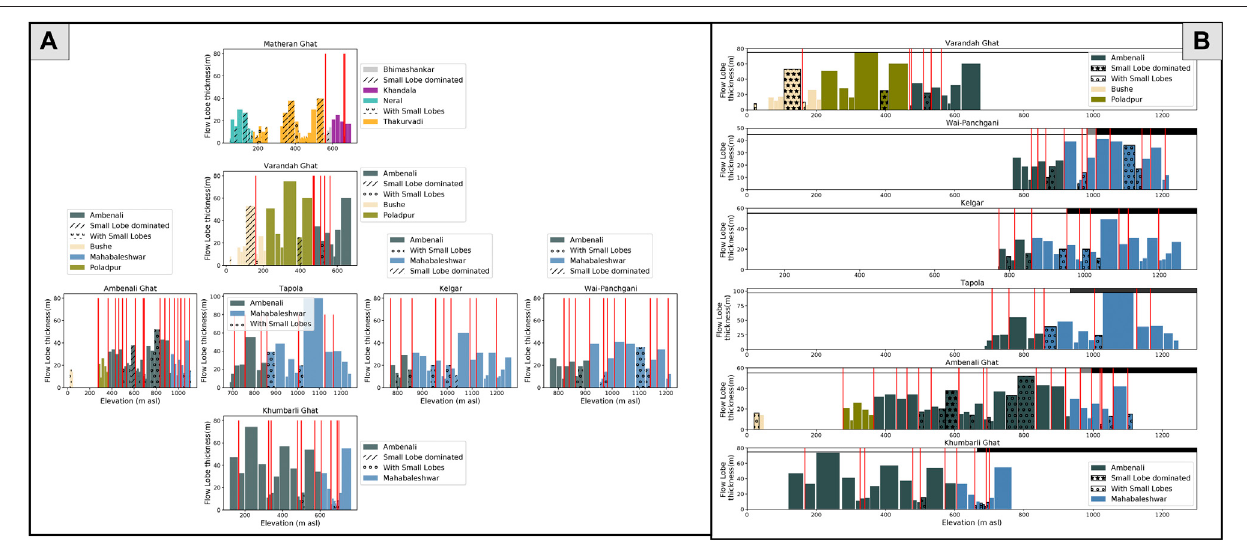
FIGURE 4 | (A) Plots of lobe thickness in each Deccan lava formation vs altitude above mean sea level for traverses in central Western Ghats area; width of bar (cid:1) lobe thickness (see Figure 1B fortraverse locations).Formations areshown bybar color(see key); +opendots (cid:1) withsmall lobes; +stars (cid:1) small-lobe-dominated. Red verticallinesshow boles (weathering horizons, see text, note the bole linethickness is not to scale). Note also that lobes > 40 m thick are uncommon. (B) Flow thickness plotted against elevation above mean sea level in six logs through parts of Western Ghats lava series. Plots given from N to S (top to bottom; see Figure 1B for traverse locations) represent distance of ∼ 80 km. Formation ornaments as on (A)